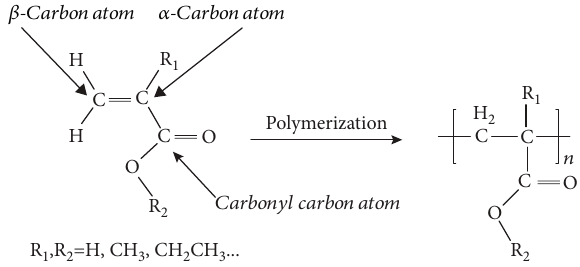
Figure 4: Structural formula of acrylates before and after and R are organic substituents and n is polymerization. Here R 1 2 the degree of polymerization. Alpha, beta and carbonyl carbon atoms are